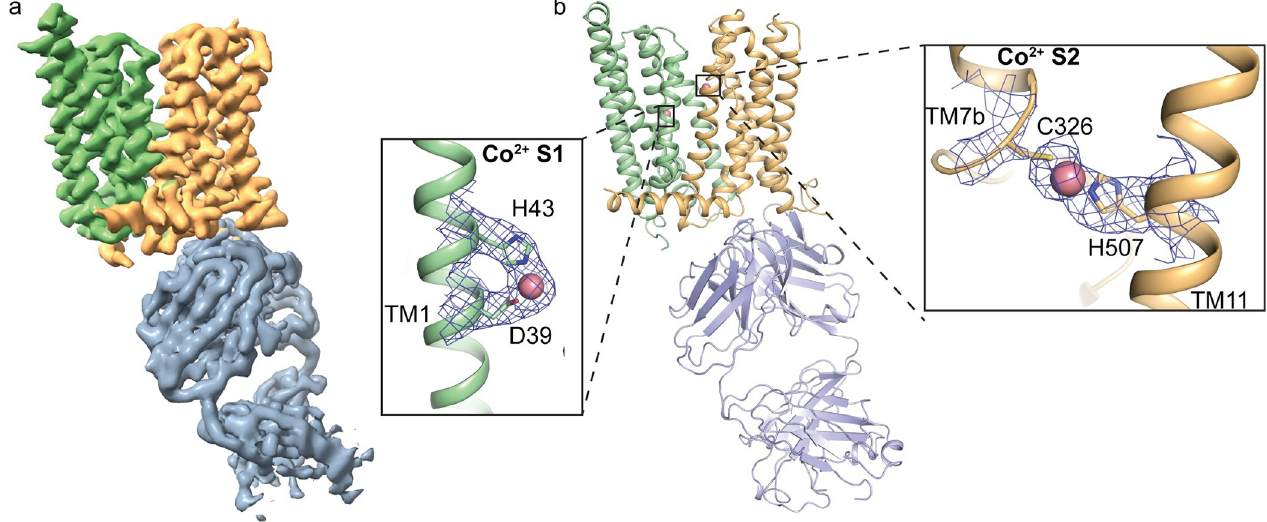
Fig 2. Structure of HsFpn in complex with 11F9 Fab. AU : AbbreviationlistshavebeencompiledforthoseusedinFigs 2 ; 3 ; 6 ; and 7 : Pleaseverifythatallentriesarecorrect : ( a ) Cryo-EM density map of HsFpn in complex with 11F9 Fab in the presence of Co 2+ . Densities for the NTD, CTD, and Fab are colored in pale green, light orange, and slate gray, respectively and contoured at 8.5 σ . ( b ) Cartoon representation of HsFpn-11F9 complex. Ligand residues of the transition metal ion binding sites, S1 and S2, are highlighted and shown as sticks. Co 2+ is rendered as a sphere (light pink). Densities for S1 and S2 are contoured at 4 σ as blue mesh. CTD, C-terminal domain; cryo-EM, cryo-electron microscopy; Fab, fragment of antigen-binding; NTD, N-terminal